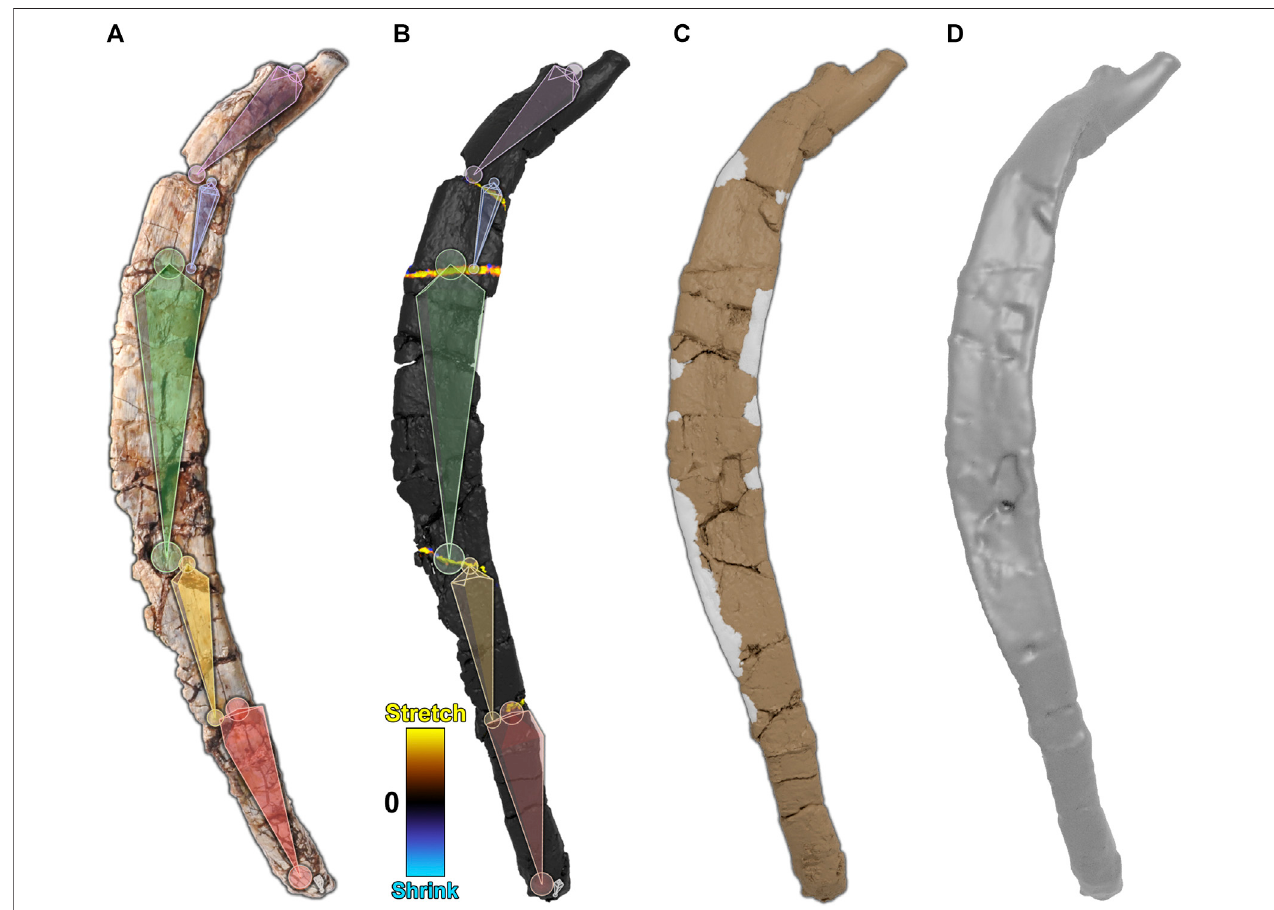
FIGURE 6 | Digital restoration of the dorsal rib. (A) The dorsal rib as preserved with armature superimposed. (B) The dorsal rib after brittle retrodeformation. A corresponding 2-color tension map documents local mesh distortions. (C) The dorsal rib with sculpted areas marked in gray. (D) The fi nal dorsal rib after smoothing.